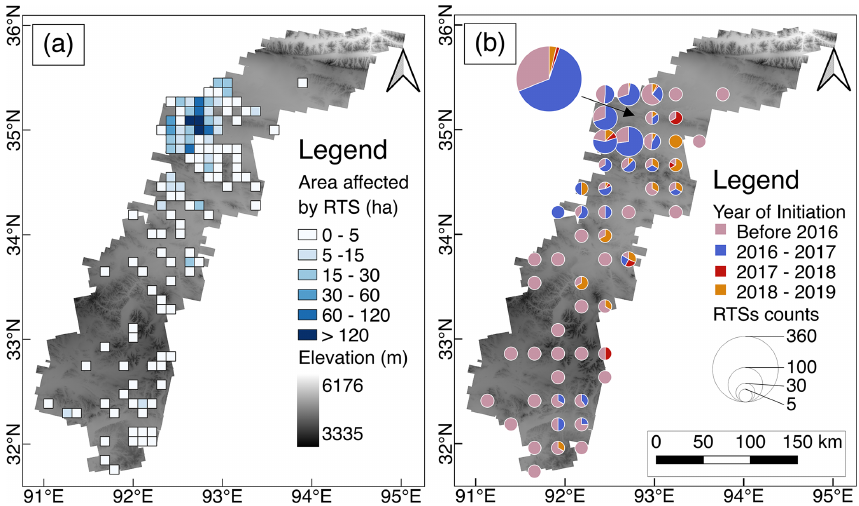
Figure 7. (a) Areas affected by RTSs in grid cells of 10km × 10km. (b) The distribution map of RTSs with different initiating years in grid cells. For clear visualization, we set the cell size as 25km × 25km in (b) . The background is a map elevation based on the Shuttle Radar Topography Mission DEM (Farr et al.,